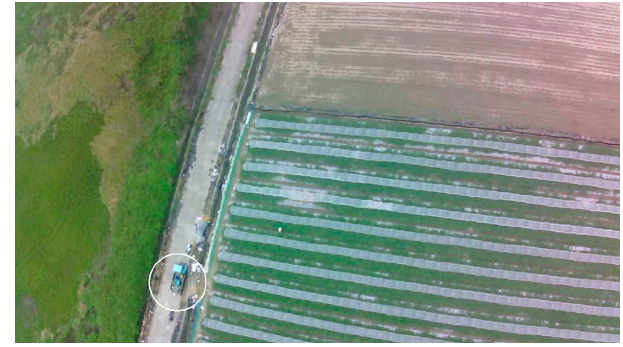
Figure 9. A blue truck reported by the on-board target identification system, marked by the identification program with a white circle.